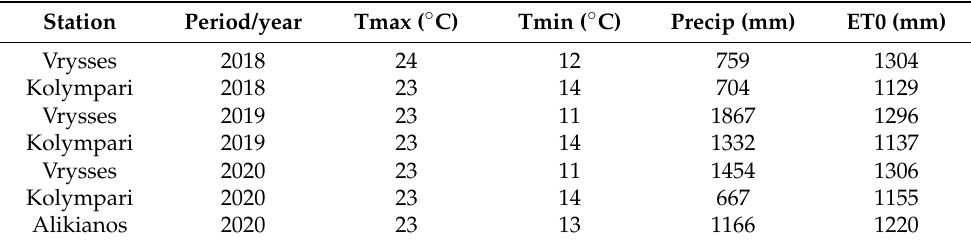
Table 1. Overview of the yearly temperature, precipitation and ET0 for the